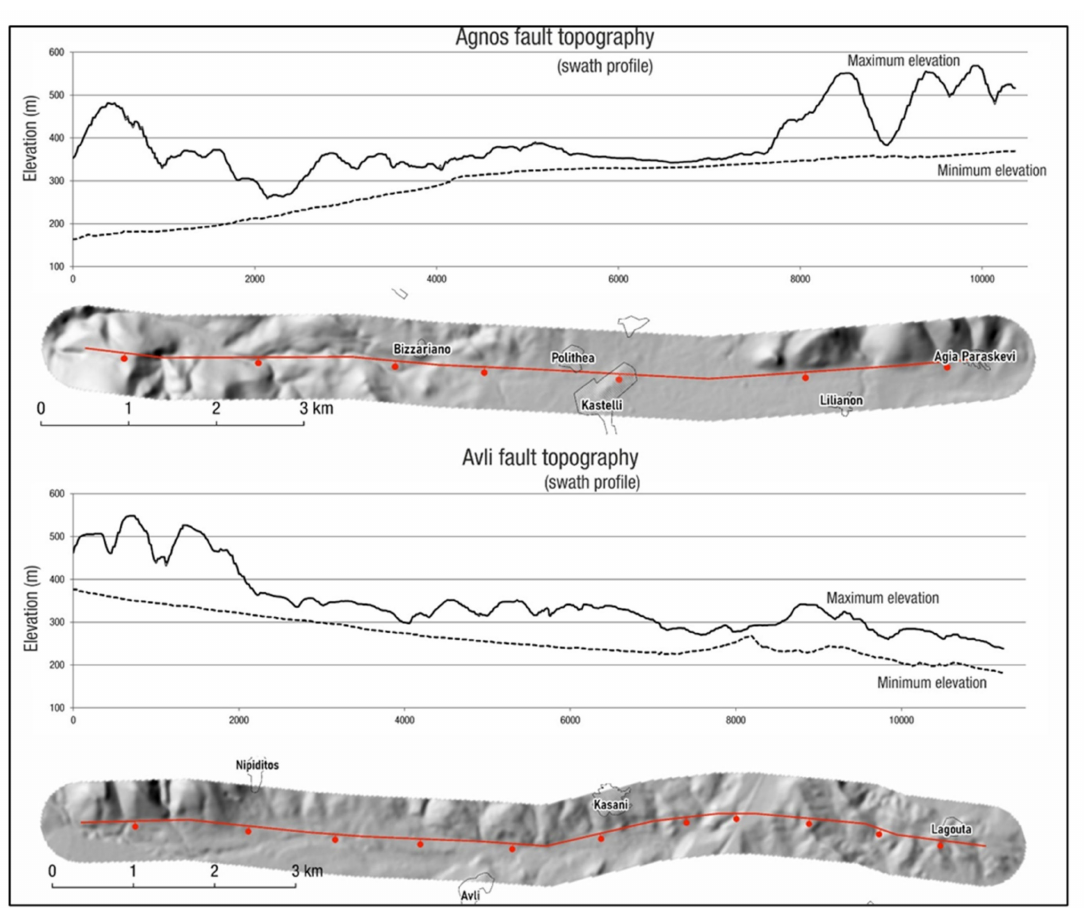
Figure 12. Along-strike DEM swaths and extraction of topographic profiles. The resultant relief is assumed to represent long-term fault-throw distribution. Upper-panel: Agnos–Kastelli fault segment, South-panel: Avli fault segment. Swath is 500 m